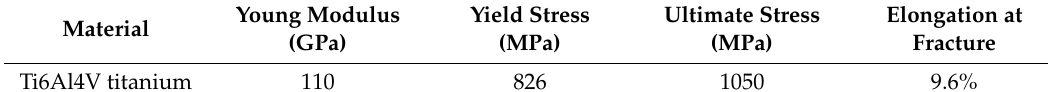
Table 1. Typical mechanical properties of Ti6Al4V (TC4) titanium alloy.